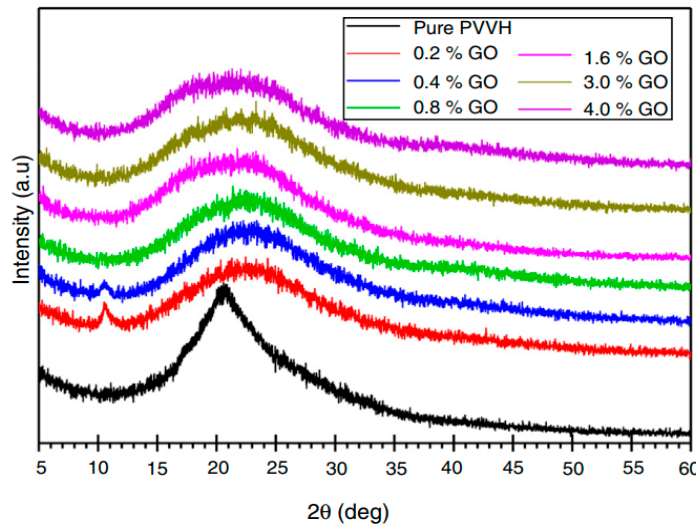
Figure 24. XRD spectra for the pure PVVH copolymer and PVVH including dissimilar GO levels [229].